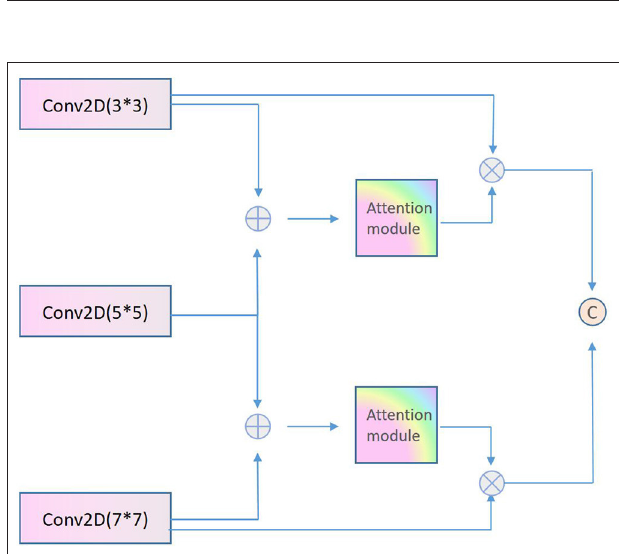
FIGURE 1 | Schematic diagram of the proposed MIFAD-Net algorithm.